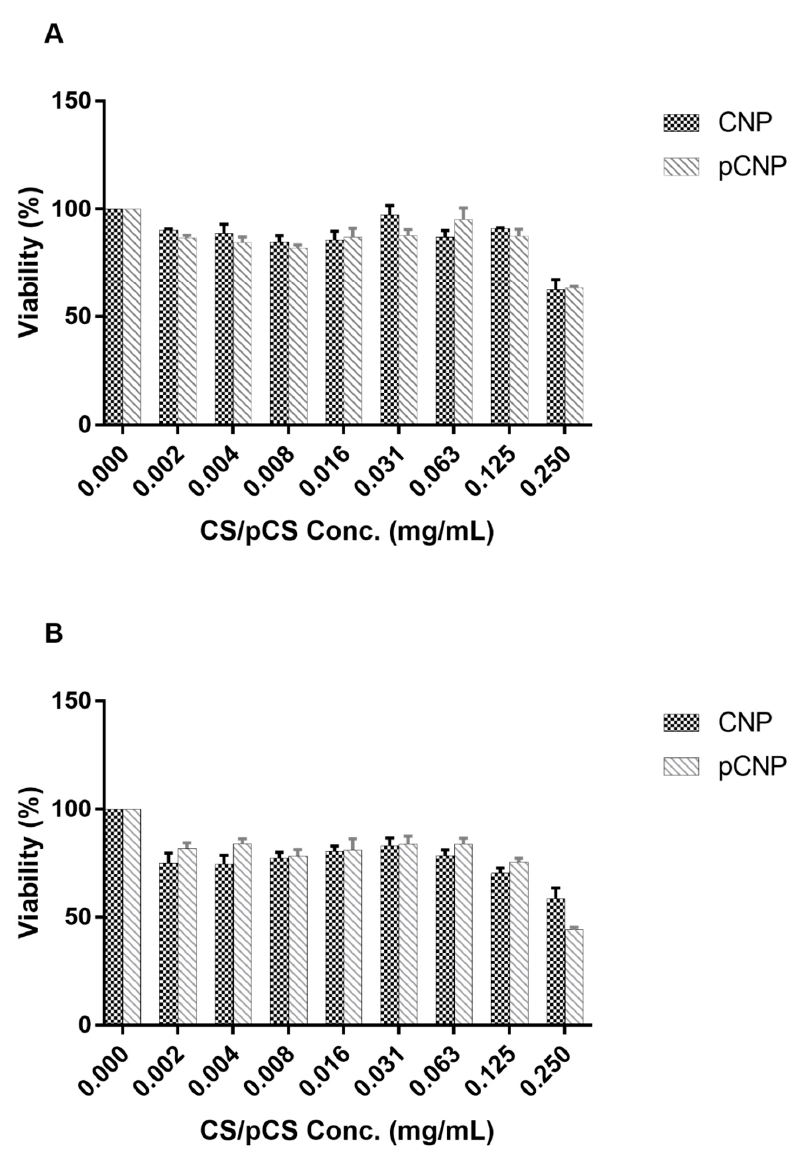
Figure 9. The cytotoxicity e ff ect of CNP and pCNP at ( A ) 24 h post-treatment and ( B ) 72 h post-treatment. Data are presented as mean ± SEM from three independent experiment replicates. Two-tailed paired t -test was performed and p > 0.05 was obtained indicating no significant di ff erent between CNP and pCNP.